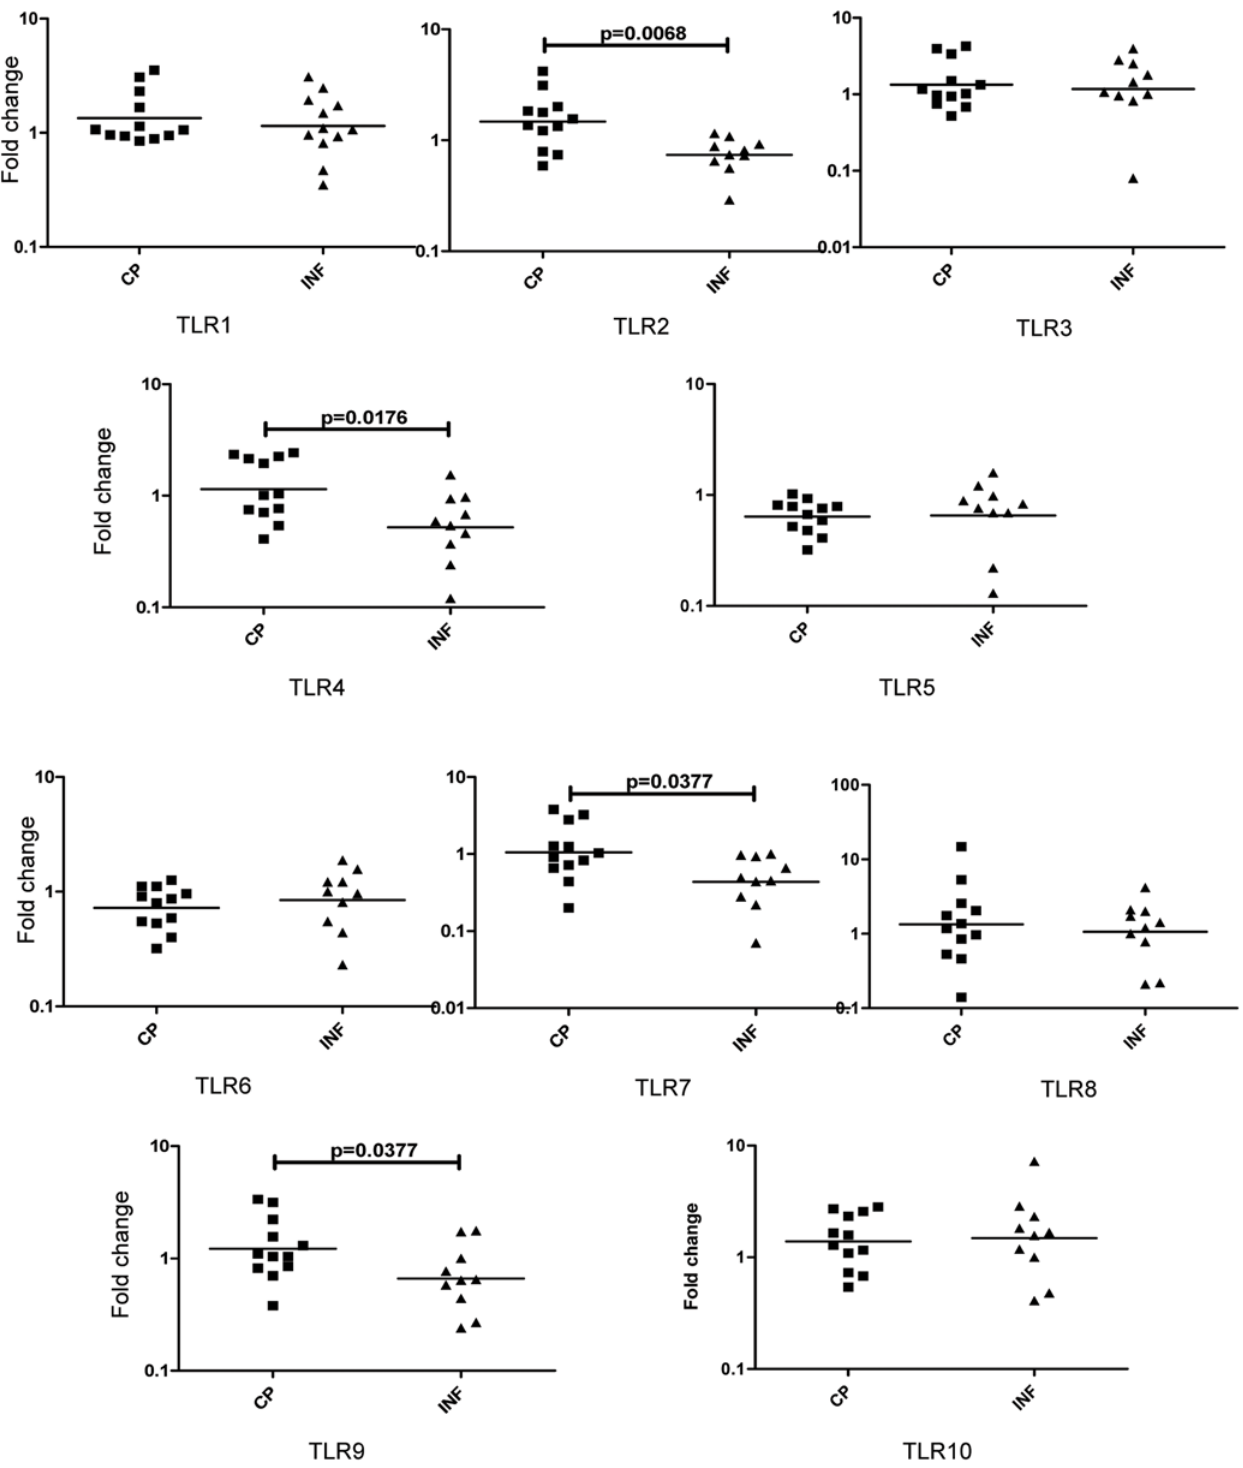
Figure 5. Filarial lymphedema is associated with increased expression of TLR2, 4, 7 and 9 mRNA. PBMCs from filarial lymphedema [CP] (n=12) and asymptomatic infected [INF] (n=10) patients were stimulated with BmA (10 m g/ml) for 24 hours, and TLR1-10 mRNA were measured by real-time RT-PCR. Results are shown as fold change over media control. P values were calculated using the Mann-Whitney test. doi:10.1371/journal.pntd.0000420.g005 Pro-inflammatory pathology in a variety of settings is offset by the the VEGF family of molecules in filarial lymphedema patients induction of a specific subset of T cells called natural or induced is currently under way. Tregs [26]. nTregs are characterized by expression of the